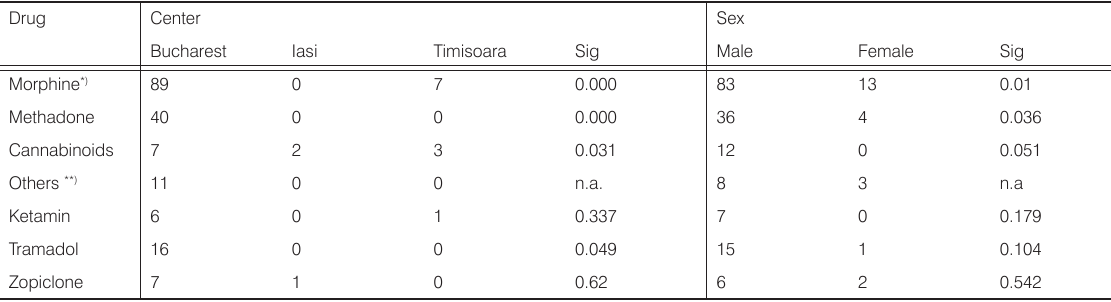
Table 3. Etiology of illegal DRDs in different centers Drug